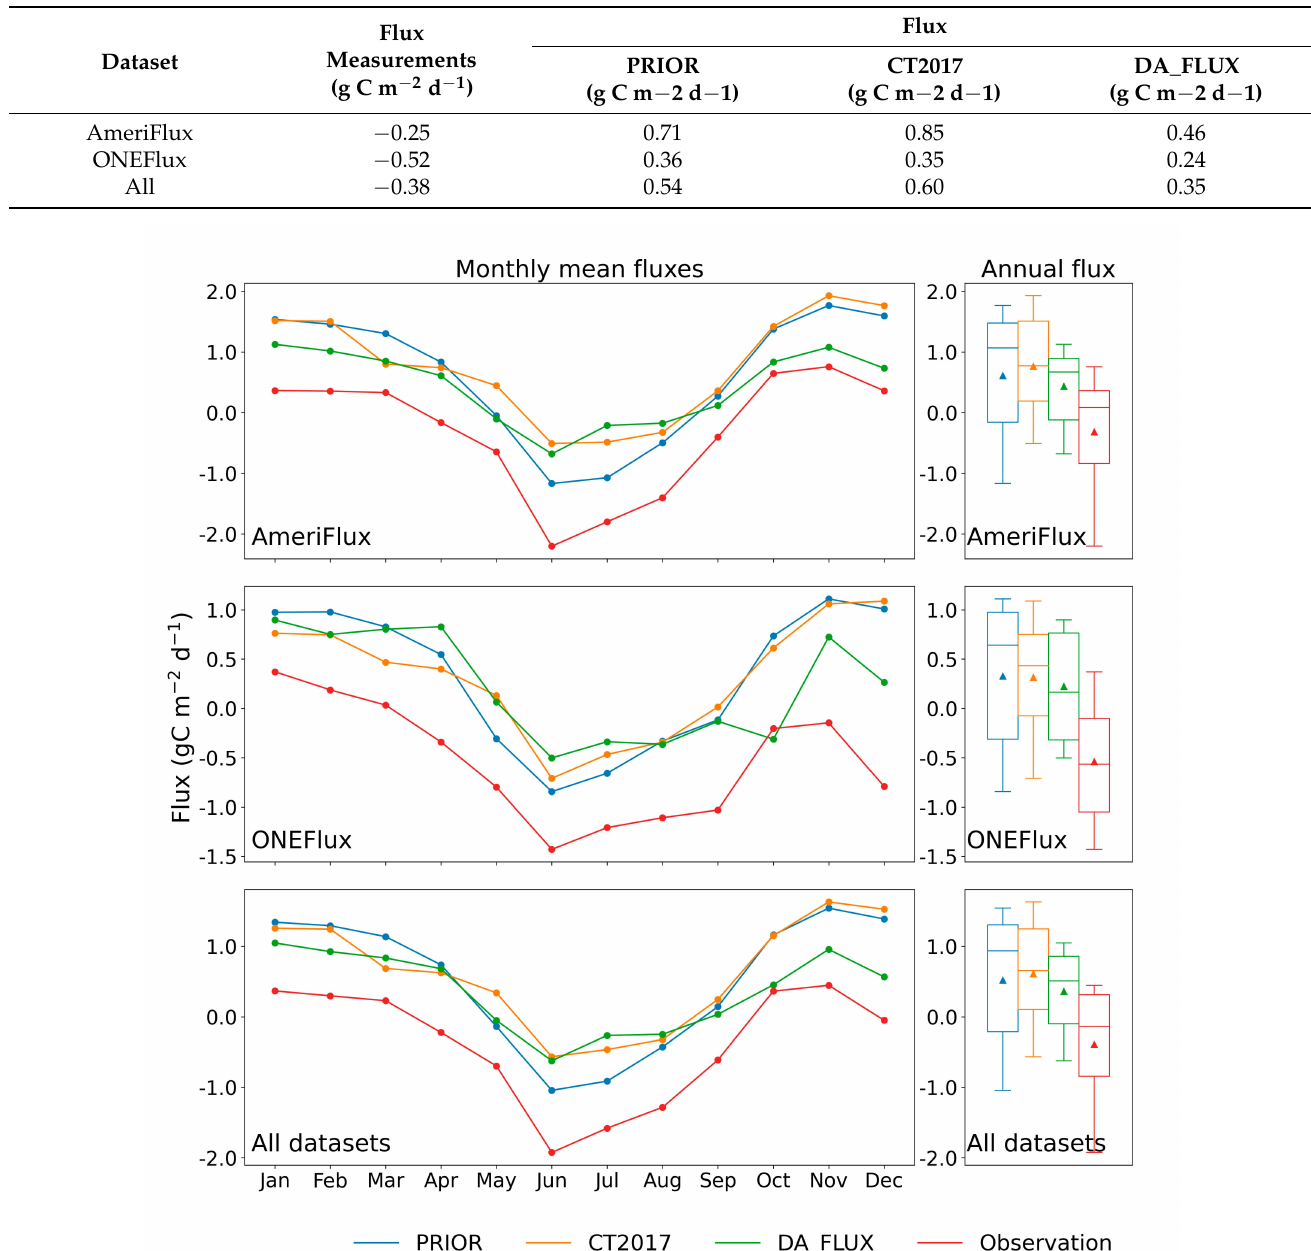
Table 4. Annual mean value of the prior (PRIOR), posterior (DA_FLUX) CO 2 flux of the DA_FLUX experiment, the posterior CO 2 flux of CT2017 interpolated to the locations of flux measurement sites, and annual mean CO 2 flux measurements of AmeriFlux and ONEFlux.